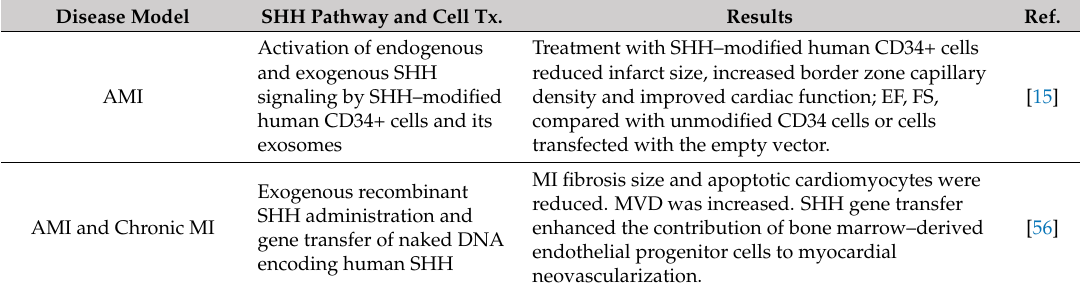
Endogenous and Exogenous Activation of Sonic Hedgehog (SHH) Signaling in Cardiovascular